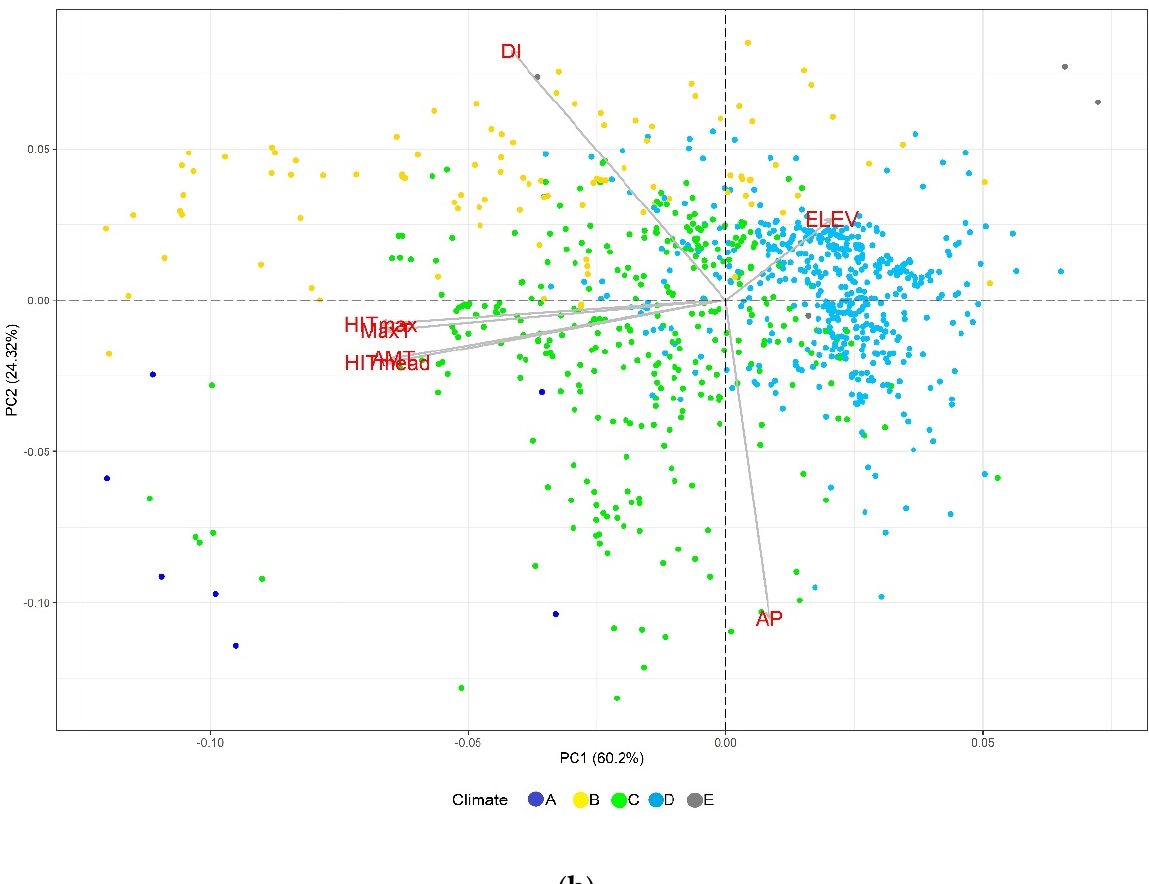
Figure 1. Principal component analysis for bioclimatic variables and elevation: ( a ) bioclimatic variables related to aridity and ( b ) temperature-related variables, calculated indices, AP, and ELEV. A = Tropical, B = Dry, C = Temperate, D = Continental, and E = Polar.